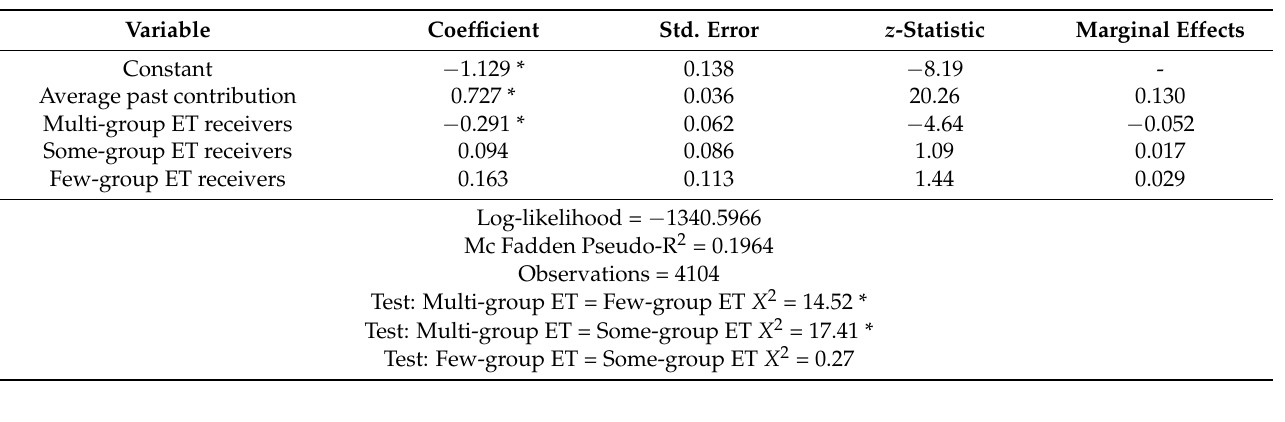
Table 5. Probit regression of the impact of average past donations and group duration on cooperative behavior, for both ET and RT. The dependent variable equals 1 if the receiver decides to cooperate and 0 otherwise. * indicates significance at the 1%